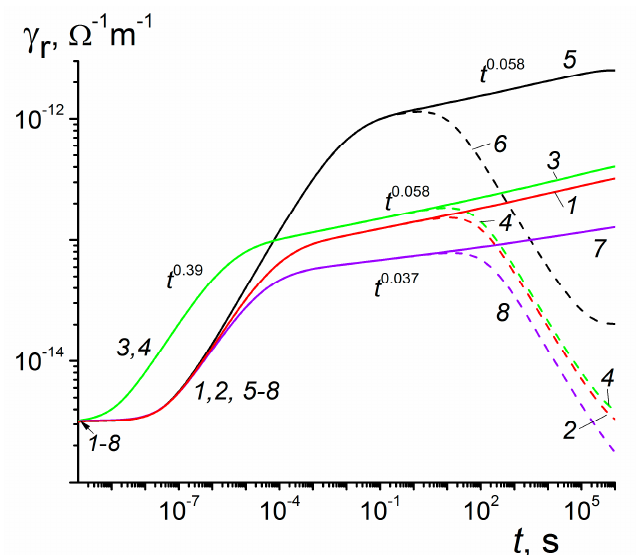
Figure 4. RIC curves calculated in a prototype polymer for the RFVm model (no transit time effects). Dose rate 10 14 (1,3,5,7, solid) and 10 20 m − 3 · s − 1 (2,4,6,8, dash). Standard set of RFVm parameters ( 1,2 ); each parameter has been changed separately: ν 0 = 9 × 10 8 s − 1 (3,4), E s = 0.4 eV (5,6) and α 2 = 0.02 (7,8). Curves for g 0 = 10 14 m − 3 · s − 1 are scaled as in Figure 3. Irradiation time 10 6 s. Curve (1) represents curve (3) in Figure 3.